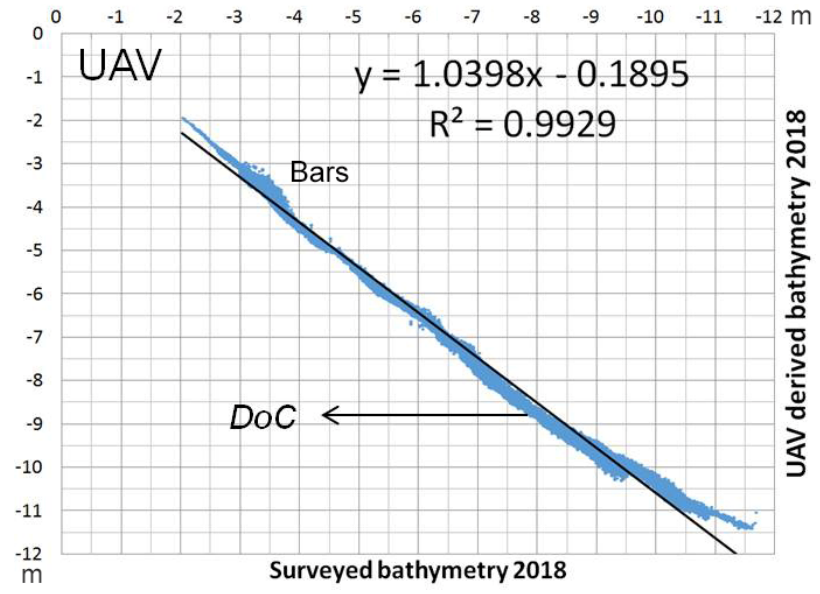
Figure 10. UDB with Stumpf’s model and real bathymetry plot.